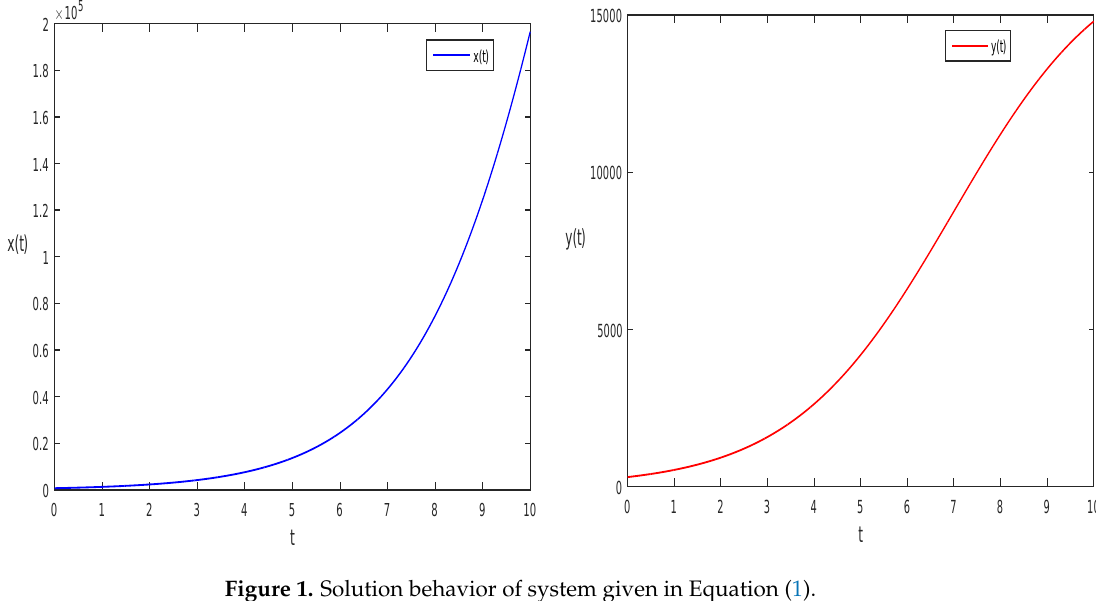
Figure 1. Solution behavior of system given in Equation (1).